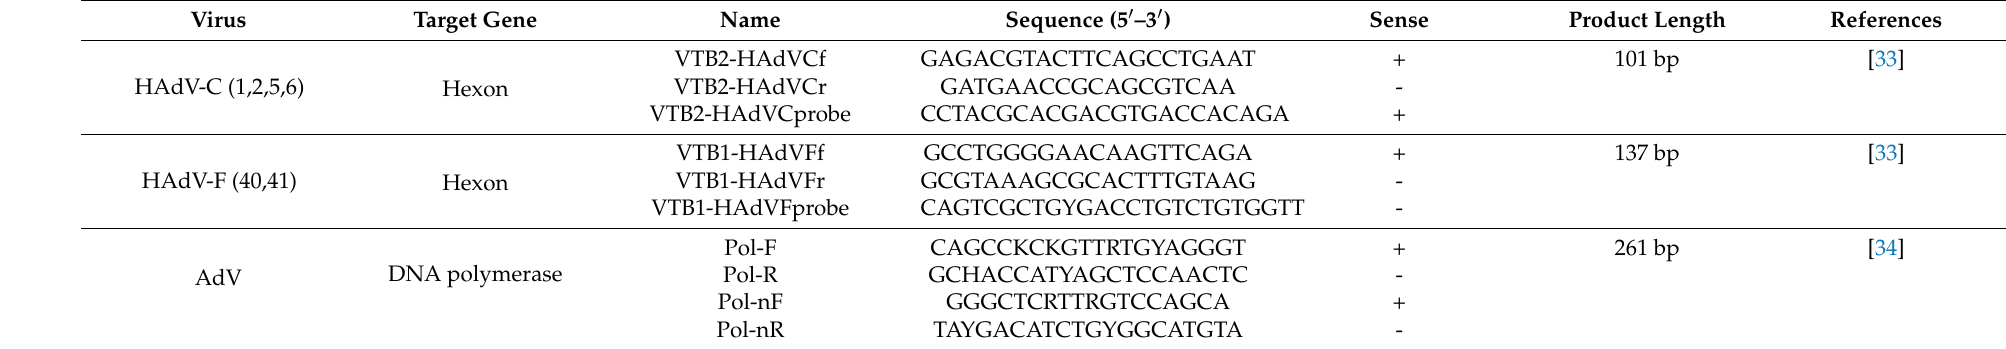
Table 1. Primers and probes used to detect Human mastadenovirus (HAdV) in nested PCR and